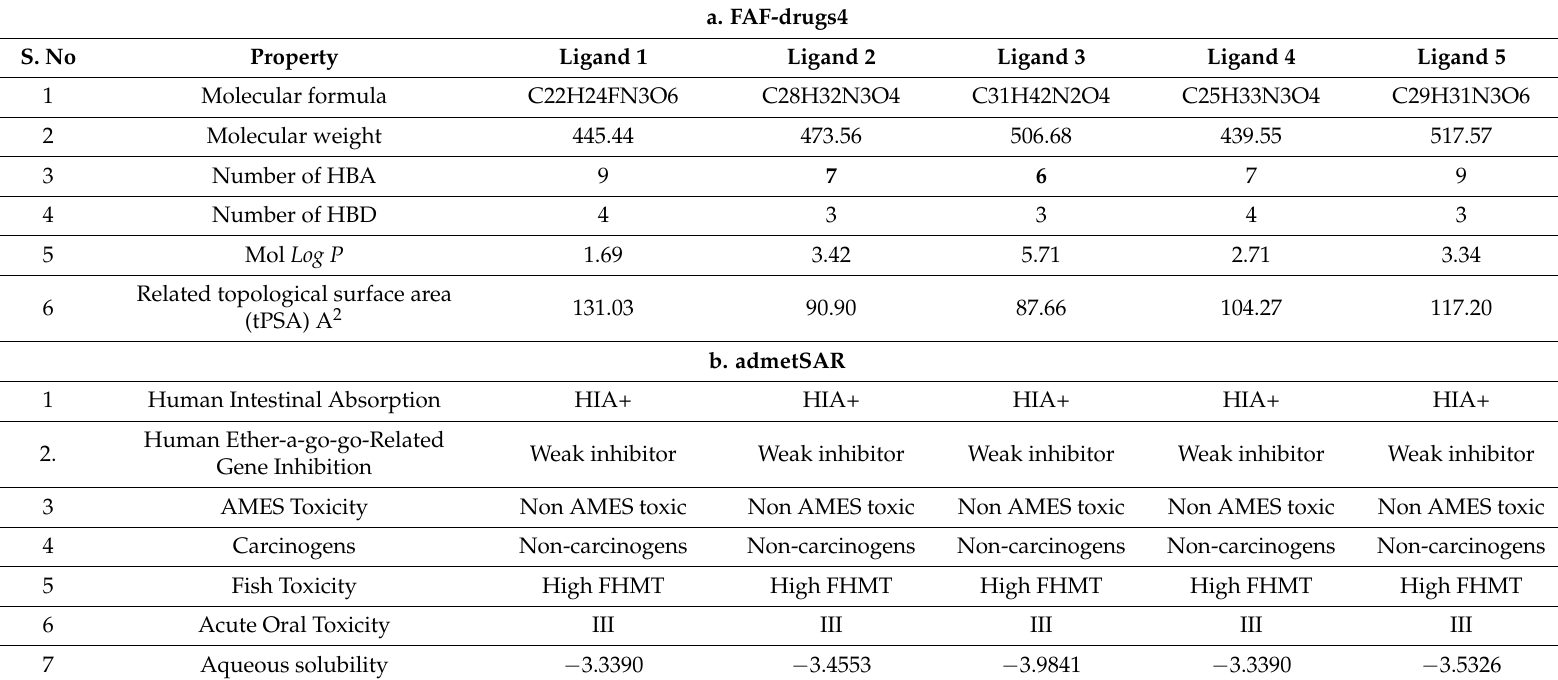
Table 6. ( a ) FAF-Drugs4 results tabulated for top five successive ligand small molecules; ( b ) admetSAR toxicity results of top five successive ligand small molecules of virtual ligand screening